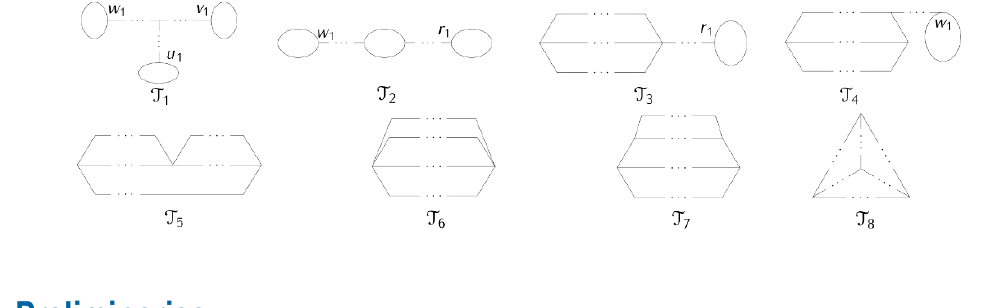
Figure 1. The eight types of bases for tricyclic